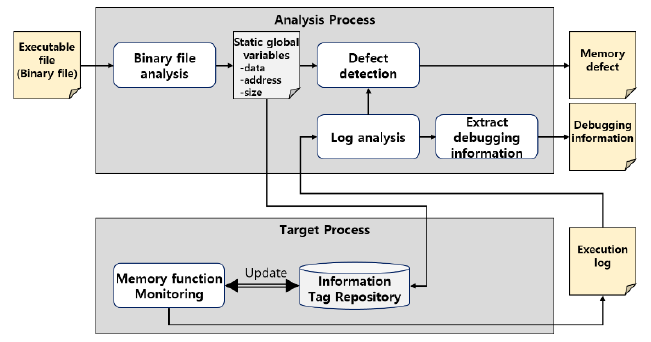
Figure 1. Overview of memory corruption detection.